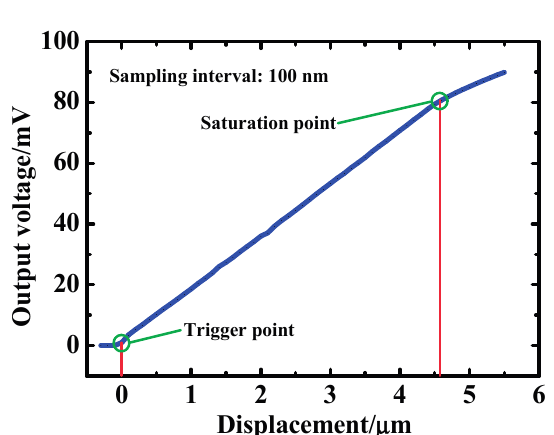
Figure 8. Axial range